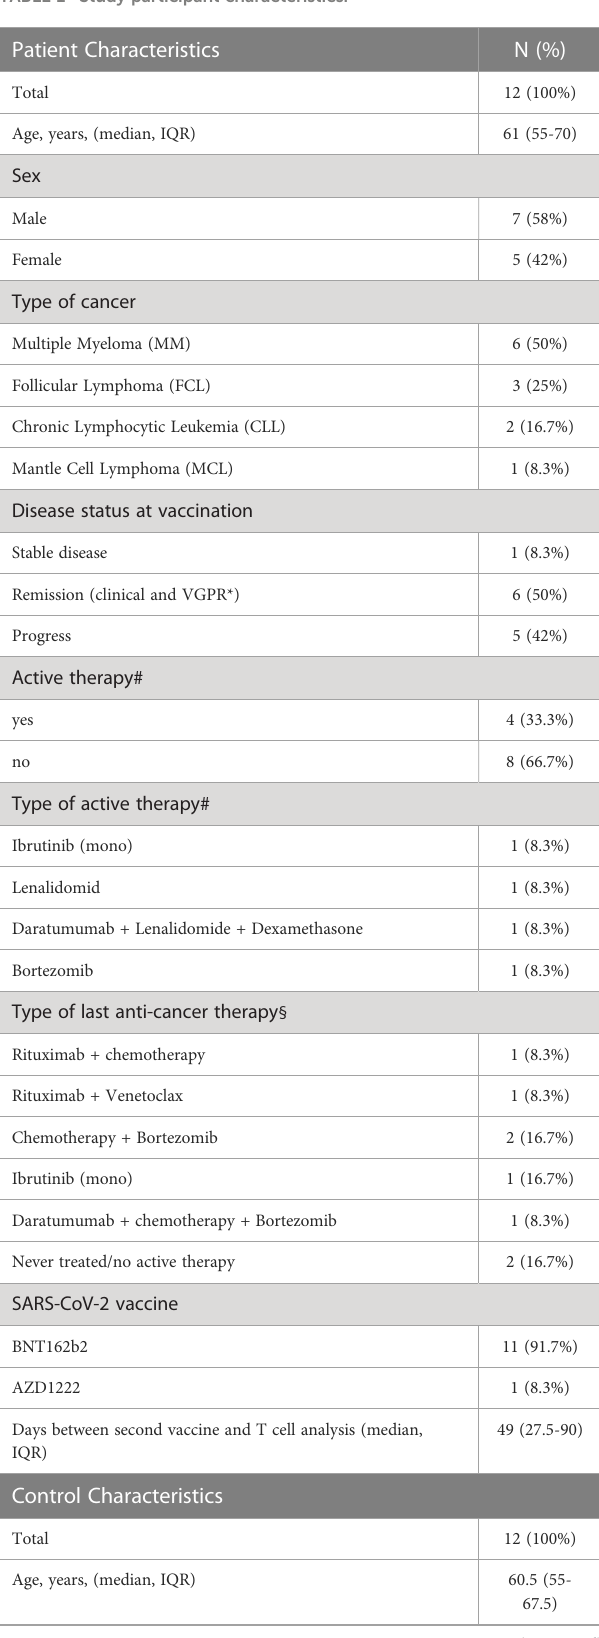
TABLE 1 Study participant